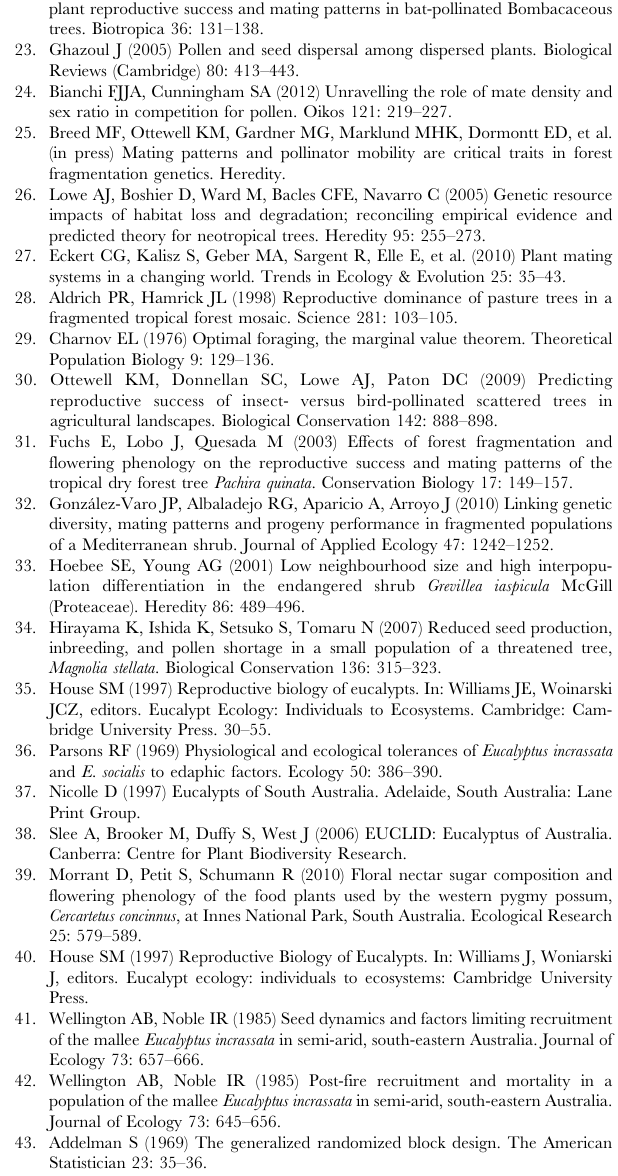
Table S2 Genetic differentiation of Eucalyptus gracilis populations. Table S3 Planting sample sizes and seedling establish- ment information after 16 months of growth at each of the three sites and for each seed provenance. Table S4 Generalized linear models of effects of seed provenance and planting site on establishment rate of Eucalyptus gracilis. Table S5 General linear model comparisons of rela- tionships between genetic predictors and establishment rate of Eucalyptus gracilis without the outlier.